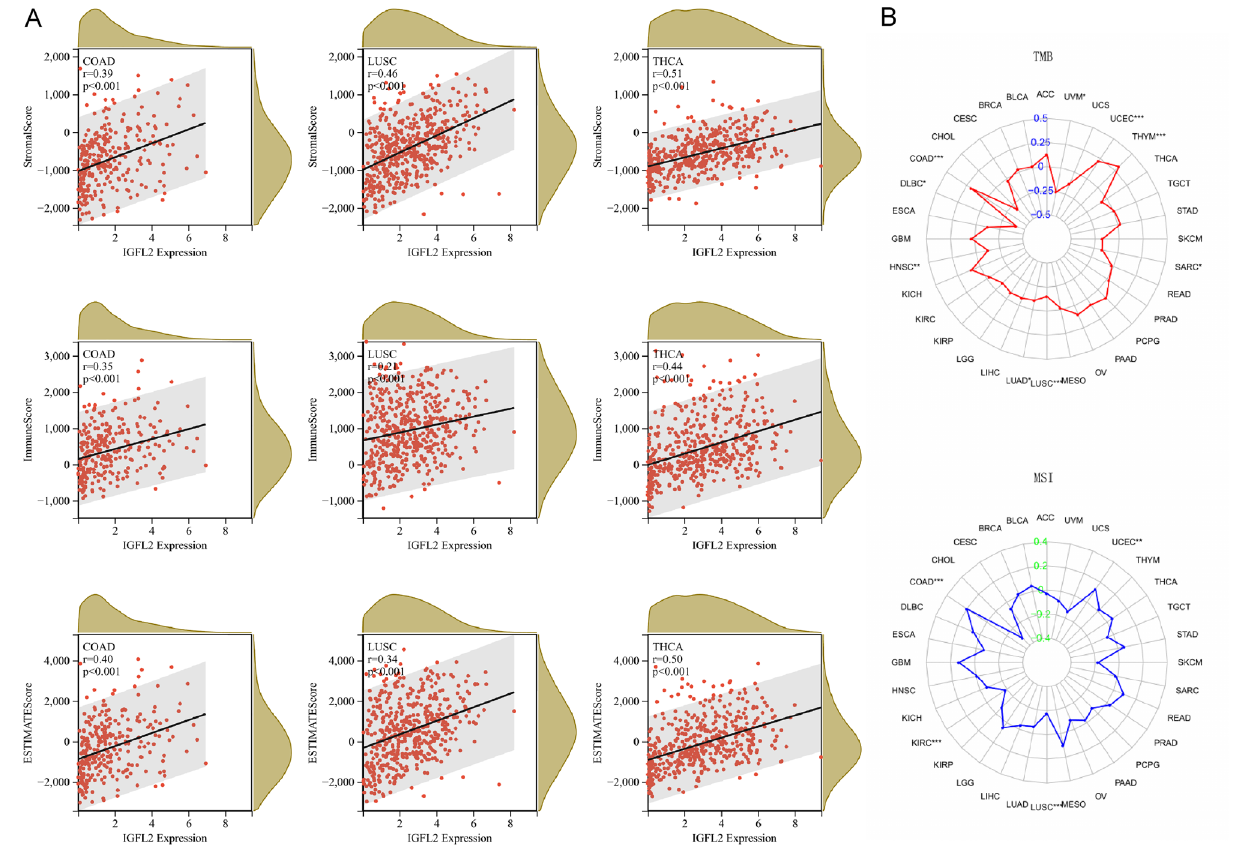
Figure 5. Correlation of scores, TMB and MSI and LCN2 expression in cancer. ( A ) Correlation of ImmuneScore, StromalScore and ESTIMATEScore with IGFL2 expression in COAD,LUSC,THCA. ( B ) Correlation of IGFL2 with TMB,MSI. *** p < 0.001 ** p < 0.01 * p <